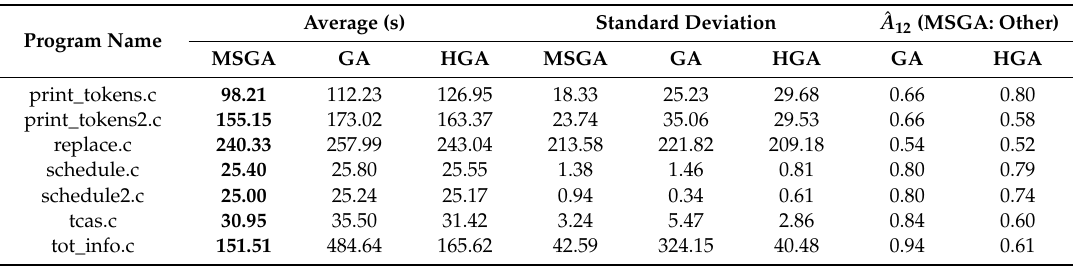
Table 11. Time performance of the MSGA, GA, and HGA for the seven programs in the software under test (SUT). Note: Bold values are the best values of each